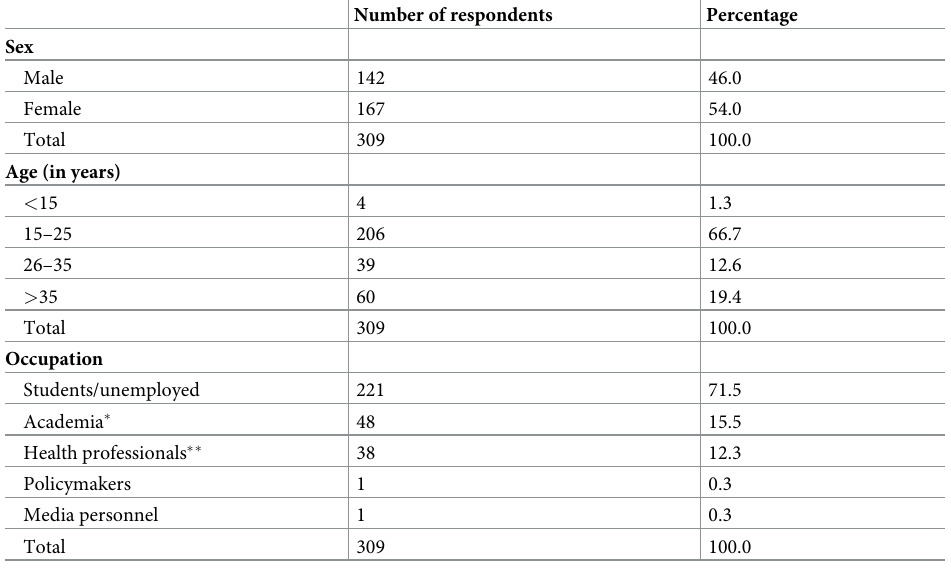
Table 1. Demographic characteristics of study